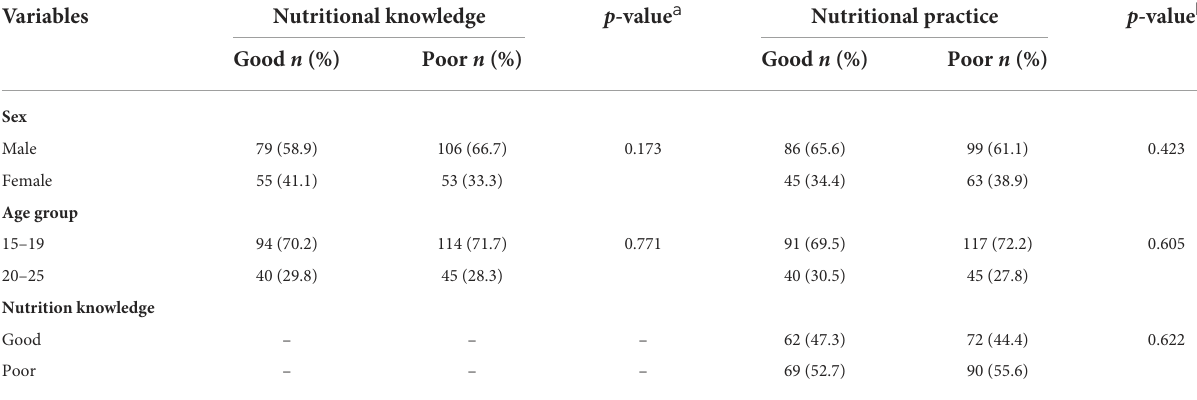
TABLE 3 Association of age, gender with nutrition knowledge and nutrition practice among Taekwondo players ( n = 293).